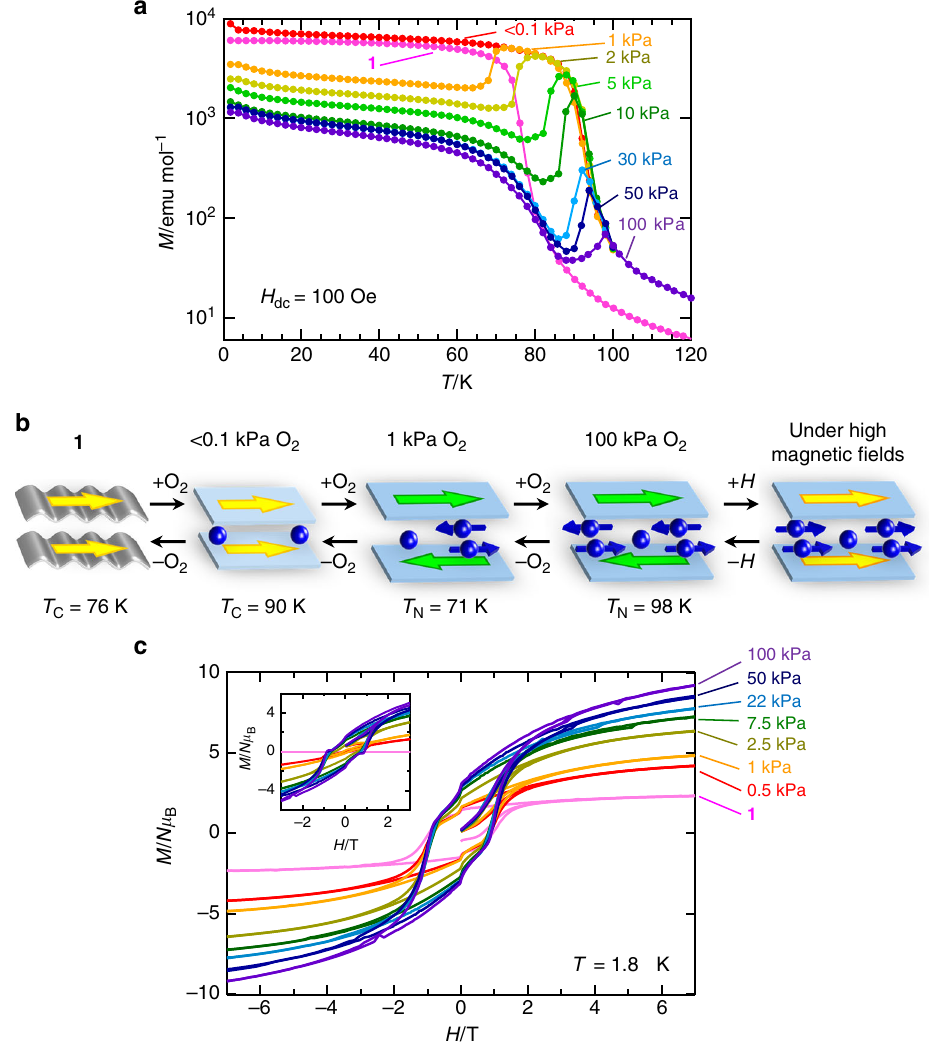
Fig. 4 Variation of magnetic properties under a paramagnetic O 2 gas. a O 2 -pressure dependence of FCM curves at a 100 Oe magnetic fi eld for 1 . b Schematic representations for the alternations of 1 ⊃ O 2 dependent on the applied O 2 pressure and external magnetic fi elds. c Field-dependence of the magnetization at 1.8 K for 1 measured at several O 2 pressures, where the inset represents the differential plots on the basis of the M − H curve for